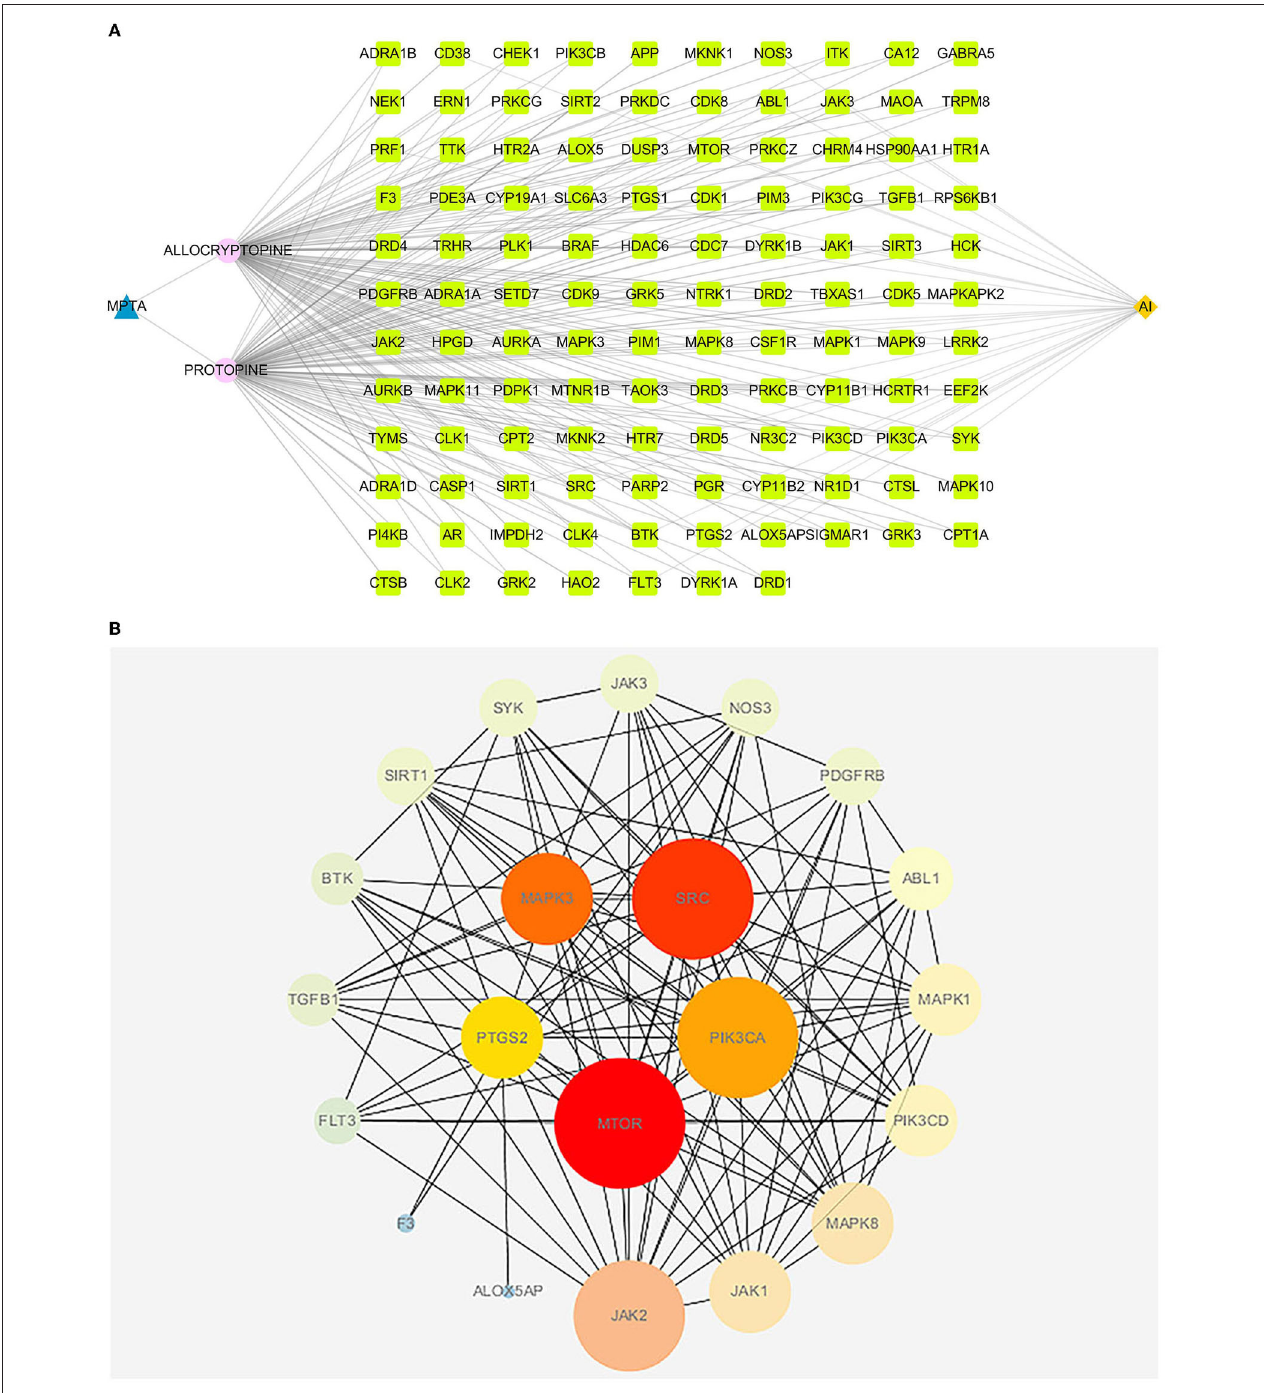
FIGURE 5 | (A) The “drug-component-disease-target” network diagram of MPTA’s anti-inflammatory effects. Blue triangular nodes represent MPTA; pink circular nodes represent active compounds; dark yellow diamond nodes represent acute inflammation (AI); and bright green square nodes represent targets of MPTA for inflammation. (B) PPI diagram of MPTA’s anti-inflammatory targets. The circular nodes represent the potential target proteins of MPTA’s anti-inflammatory action; the larger the radius of the nodes, the greater their degree; the lines between the nodes represent the interaction between the targets; the darker the color of the lines, the stronger the interaction between the nodes. The five darkest nodes in the center are the core targets calculated by the Hubba algorithm.